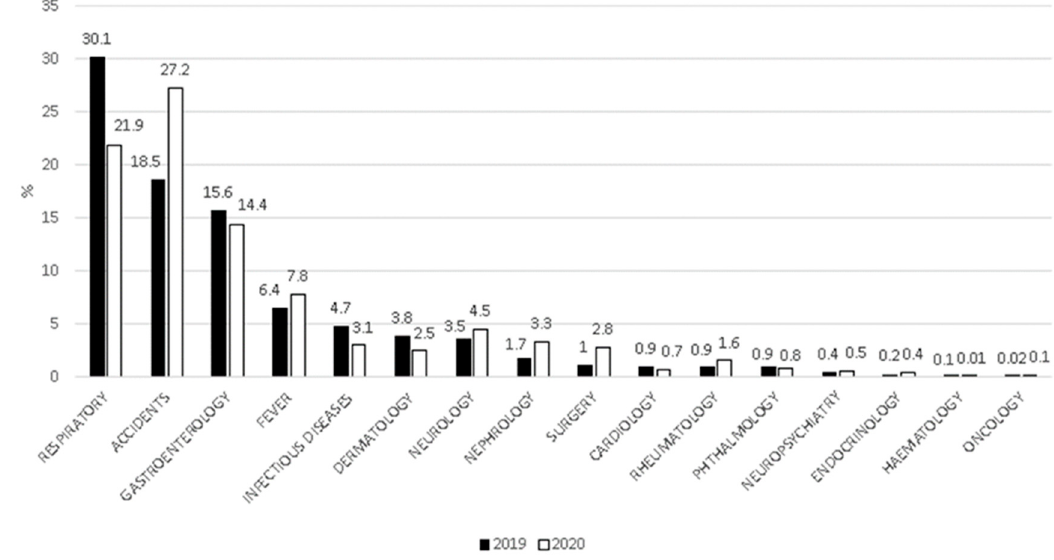
Figure 2. Proportion of pediatric ER diagnoses from 9 March to 3 May 2019, and the same period in 2020.